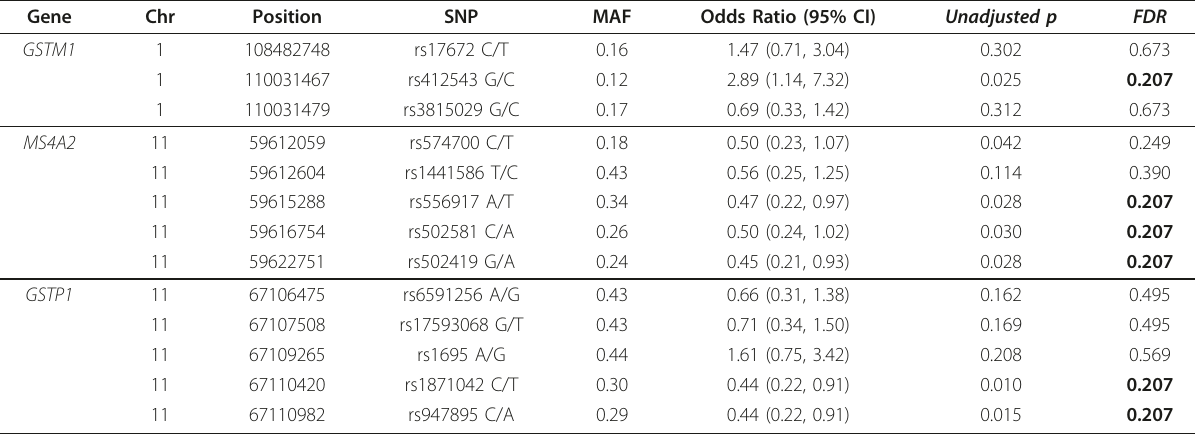
Table 2 Association between SNPs and asthma